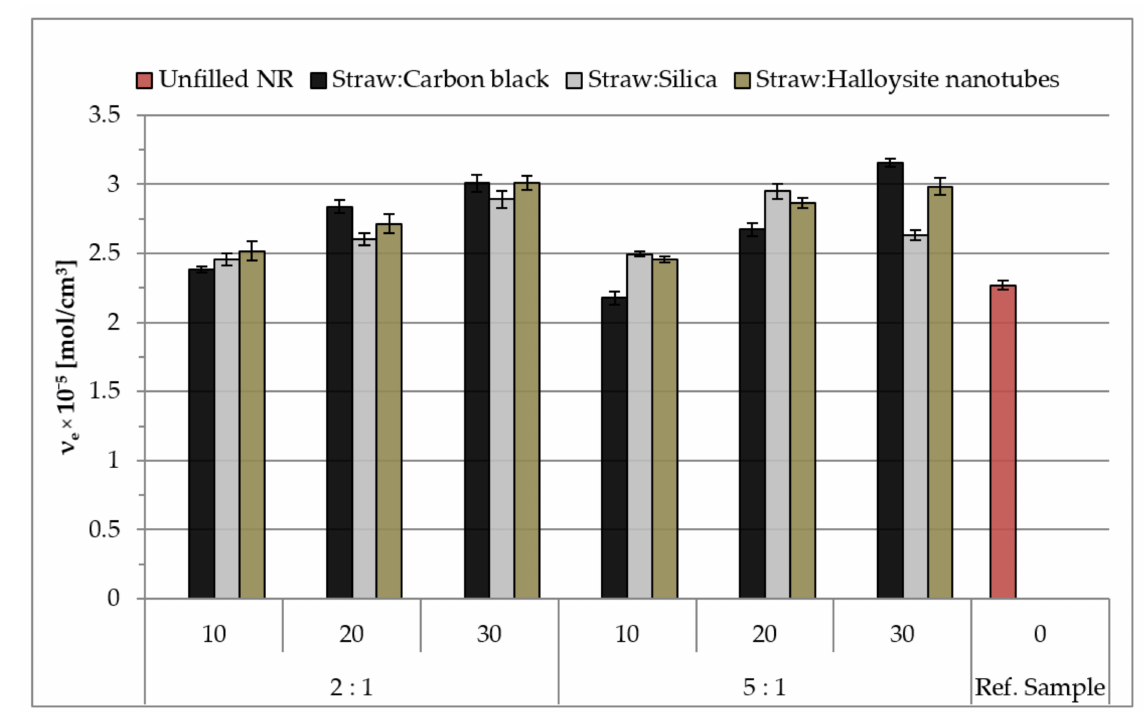
Figure 12. The density of network nodes of